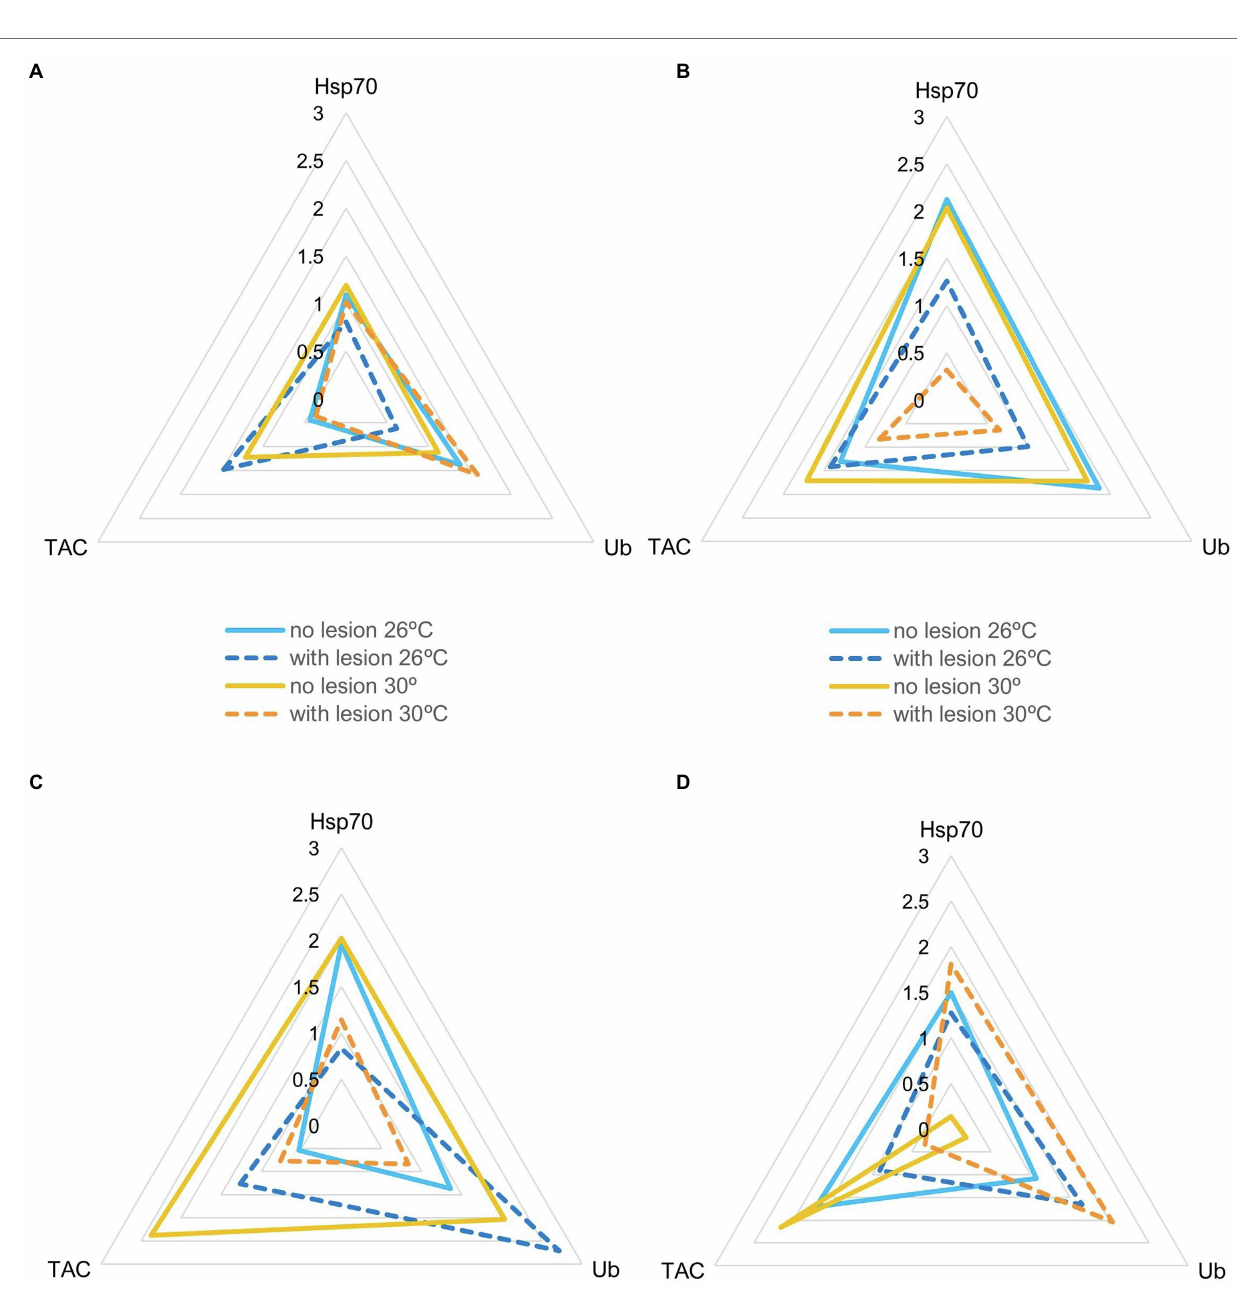
FIGURE 5 | Star plots with mean scores obtained in each experimental condition for thermosensitive coral species that only survived up to 30 ° C (N total = 20 fragments per species, N = 5 specimens of each species per experimental condition). (A) Acropora tenuis (IBR 26 + no lesion = 1.29; IBR 26 + lesion = 1.30; IBR 30 + no lesion = 2.07; IBR 30 + lesion = 1.28); (B) Echinopora lamellosa (IBR 26 + no lesion = 4.58; IBR 26 + lesion = 2.22; IBR 30 + no lesion = 4.97; IBR 30 + lesion = 0.49); (C) Montipora capricornis BM (IBR 26 + no lesion = 2.21; IBR 26 + lesion = 3.37; IBR 30 + no lesion = 6.86; IBR 30 + lesion = 1.22); and (D) M. capricornis GM (IBR 26 + no lesion = 3.00; IBR 26 + lesion = 2.38; IBR 30 + no lesion = 0.35; IBR 30 + lesion =